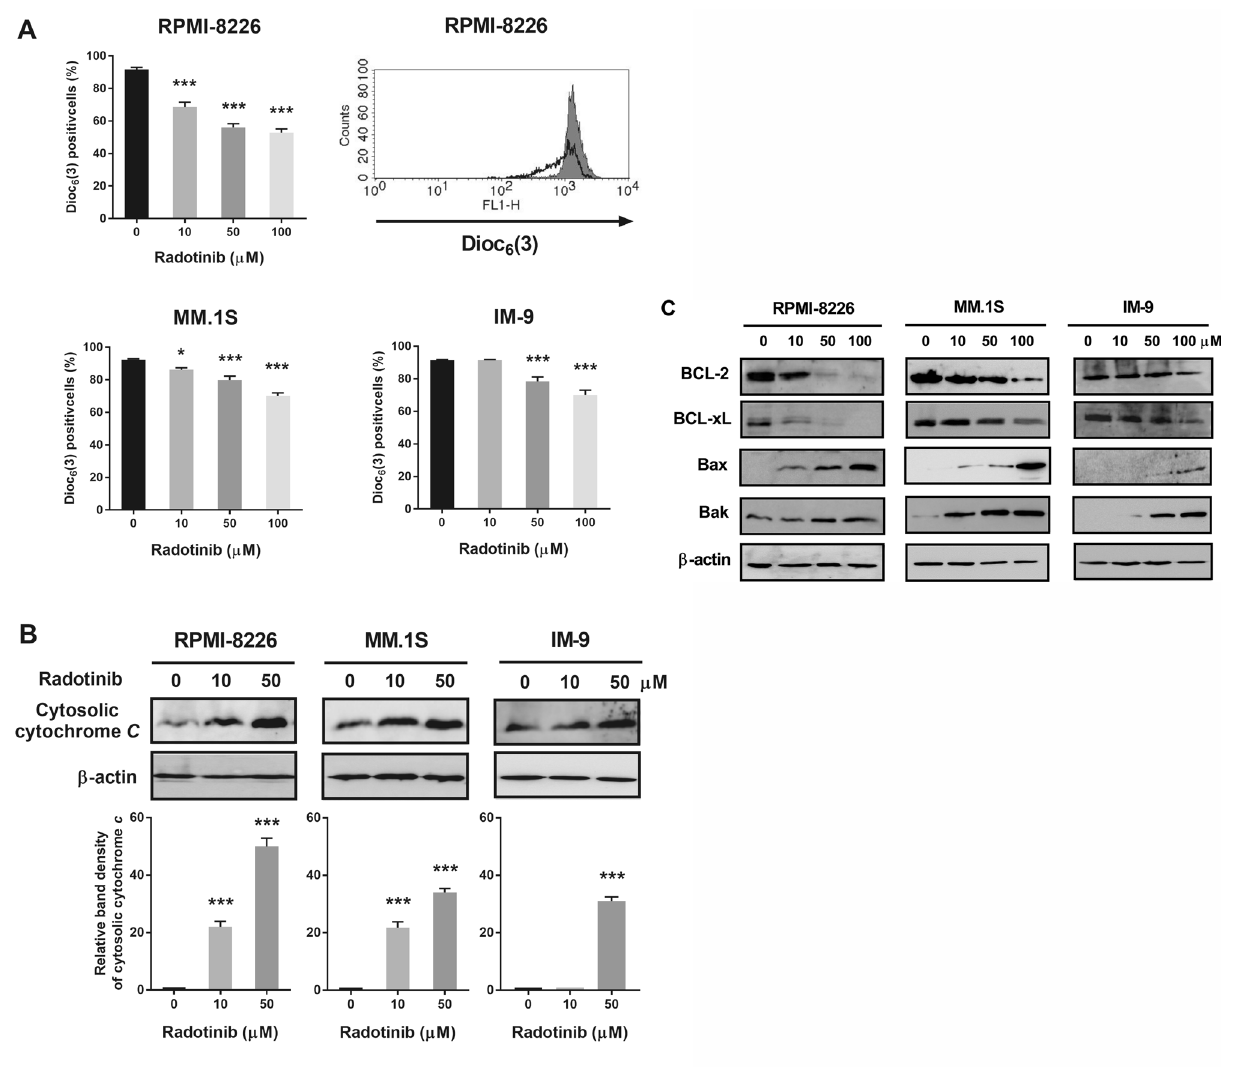
Figure 4. Radotinib-induced apoptosis by activation of the mitochondrial pathway. RPMI-8226, MM.1S, and IM-9 cells were incubated with 0, 10, 50, and 100 μM radotinib for 72 h. ( A ) Effect of radotinib on mitochondrial membrane potential (MMP, ΔΨm ). Filled histogram indicates MMP in cells treated with 0 μM radotinib, and open histogram indicates MMP in RPMI-8226 cells treated with 100 μM radotinib. ( B ) Effect of radotinib on cytosolic cytochrome C levels. ( C ) Effects of radotinib on the expression of BCL-2 family proteins (including BCL-2, BCL-xL, Bax, and Bak). The membrane was stripped and reprobed with anti-β-actin mAb to confirm equal loading. Data present mean ± SEM.; * P < 0.05.; *** P < 0.001. *Significantly different from control